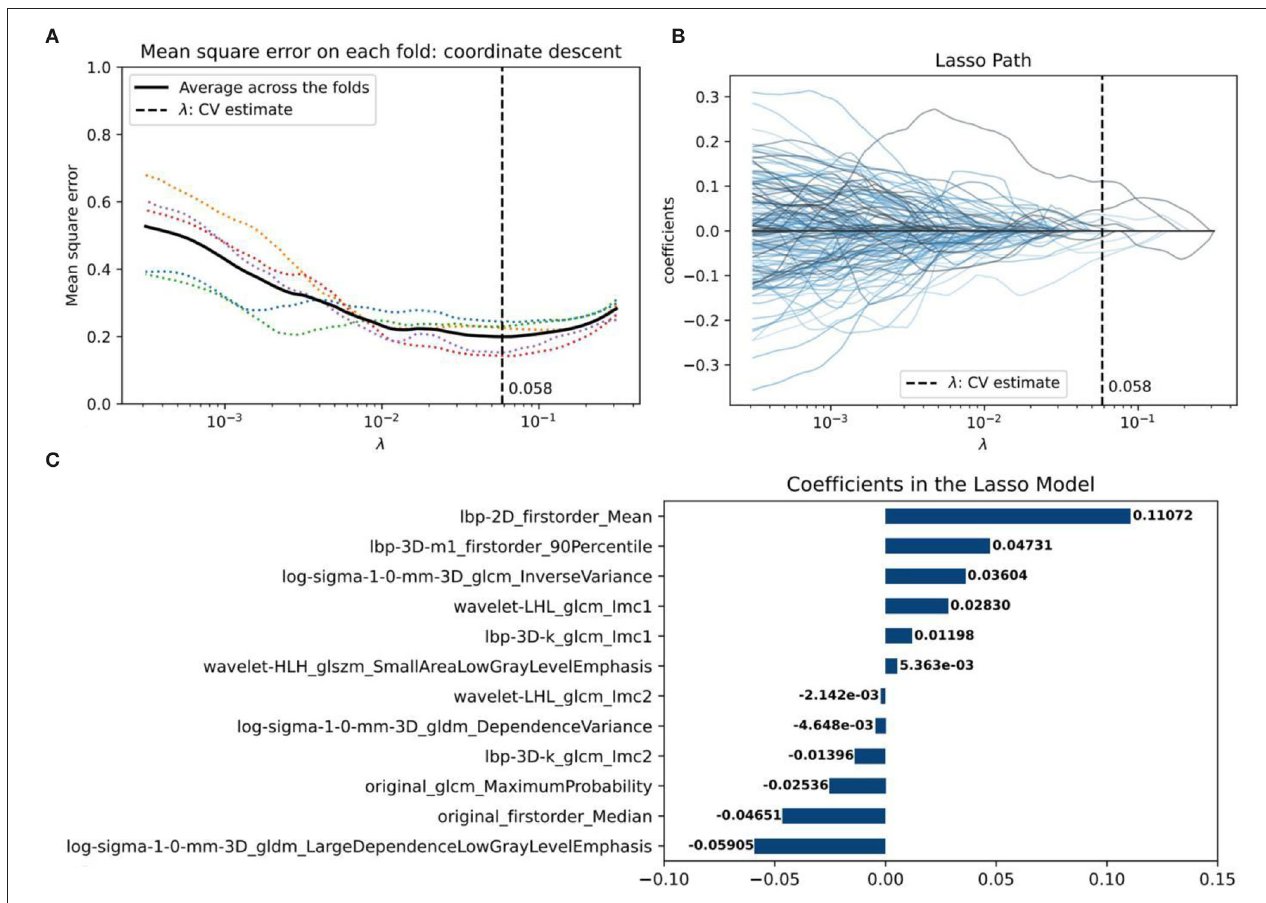
FIGURE 2 | The radiomics feature selection using the least absolute shrinkage and selection operator (LASSO) regression algorithm. (A) The coefficient lambda of the penalty term in LASSO was seen as a hyperparameter and was tuned via the 5-fold cross-validation (CV) method. The x-axis represents the values of lambda. The black curve represents the average mean square error (MSE) for each model given lambda. The vertical line marks the value of the best lambda, which is 0.058 because, at this time, the average MSE reaches its lowest point. (B) Radiomics feature coefficient reduction path curves. Finally, 12 non-zero factors were selected. (C) The histogram of the resulting radiomics feature coefficients from the optimal LASSO